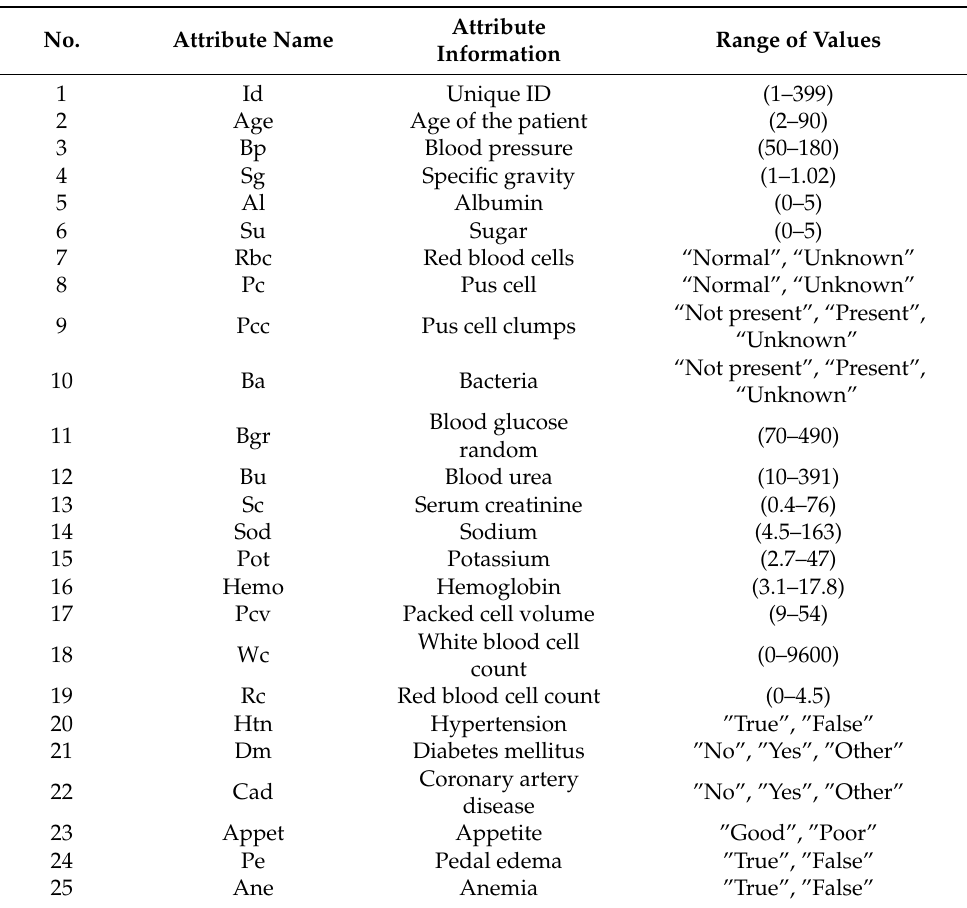
Table 6. Dataset description of kidney